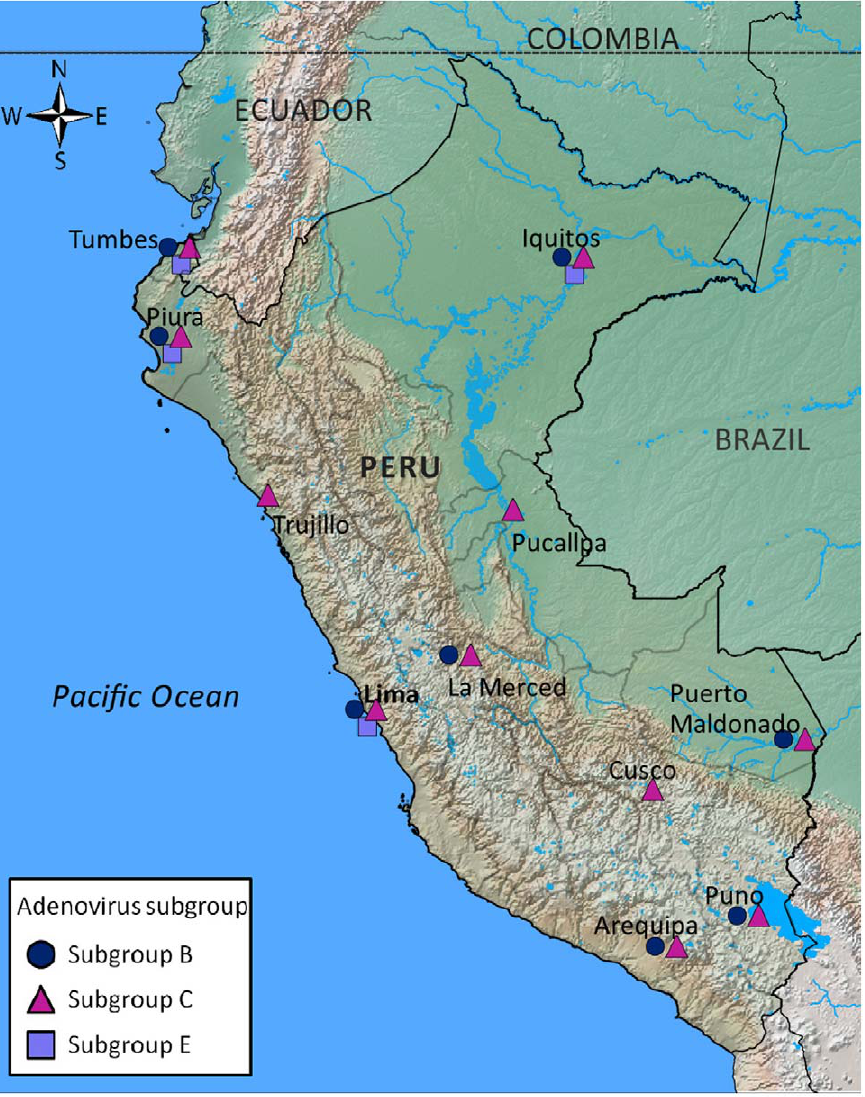
Figure 5. Map of Peru with the distribution of the HAdv subgroups among the 11 sentinel surveillance provinces encompassing 14 cities and 38 health centers. The provinces were: Tumbes (Tumbes: 3 sites); Piura (Piura: 2 sites, Sullana: 3 sites); La Libertad (Trujillo: 2 sites); Lima (Lima: 6 sites); Arequipa (Arequipa: 1 site); Puno (Puno: 1 site, Juliaca: 1 site); Cusco (Cusco: 1 site); Madre de Dios (Puerto Maldonado: 3 sites); Junin (La Merced: 1 site); Ucayali (Pucallpa: 1 site); Loreto (Iquitos: 12 sites, Yurimaguas: 1 site). Peru, 2006–2010.